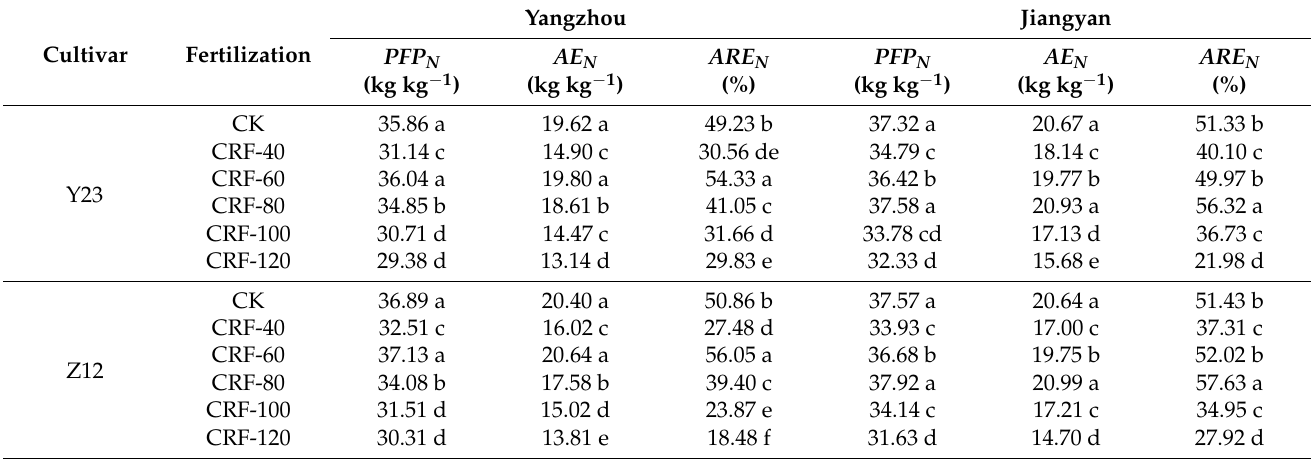
Table 6. Nitrogen use efficiencies of wheat under different fertilizer treatments in Yangzhou and Jiangyan.